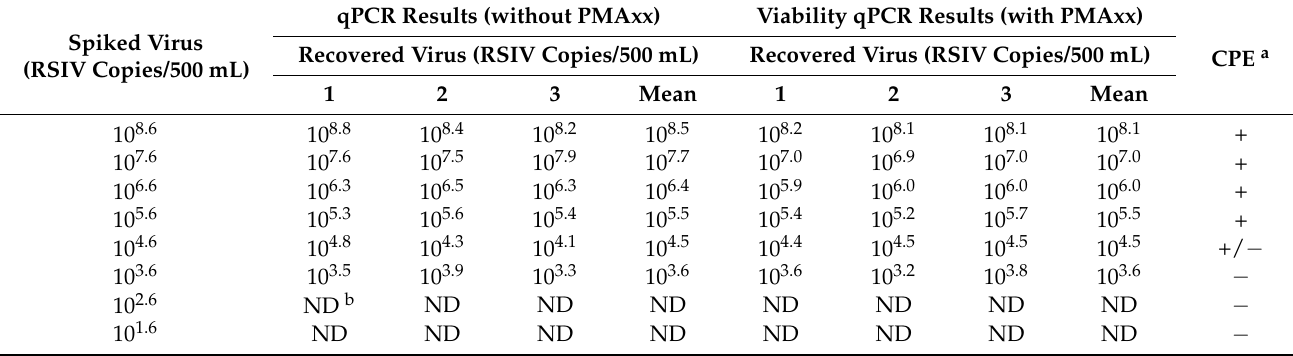
Table 1. Recovery of red sea bream iridovirus (RSIV) from experimentally virus-spiked seawater, as determined using quantitative polymerase chain reaction (qPCR), viability qPCR, and cell culture